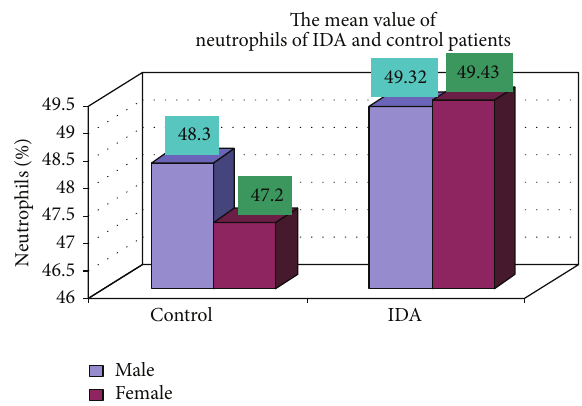
Figure 13: Showing mean value platelets of control and iron deficiency anemia.